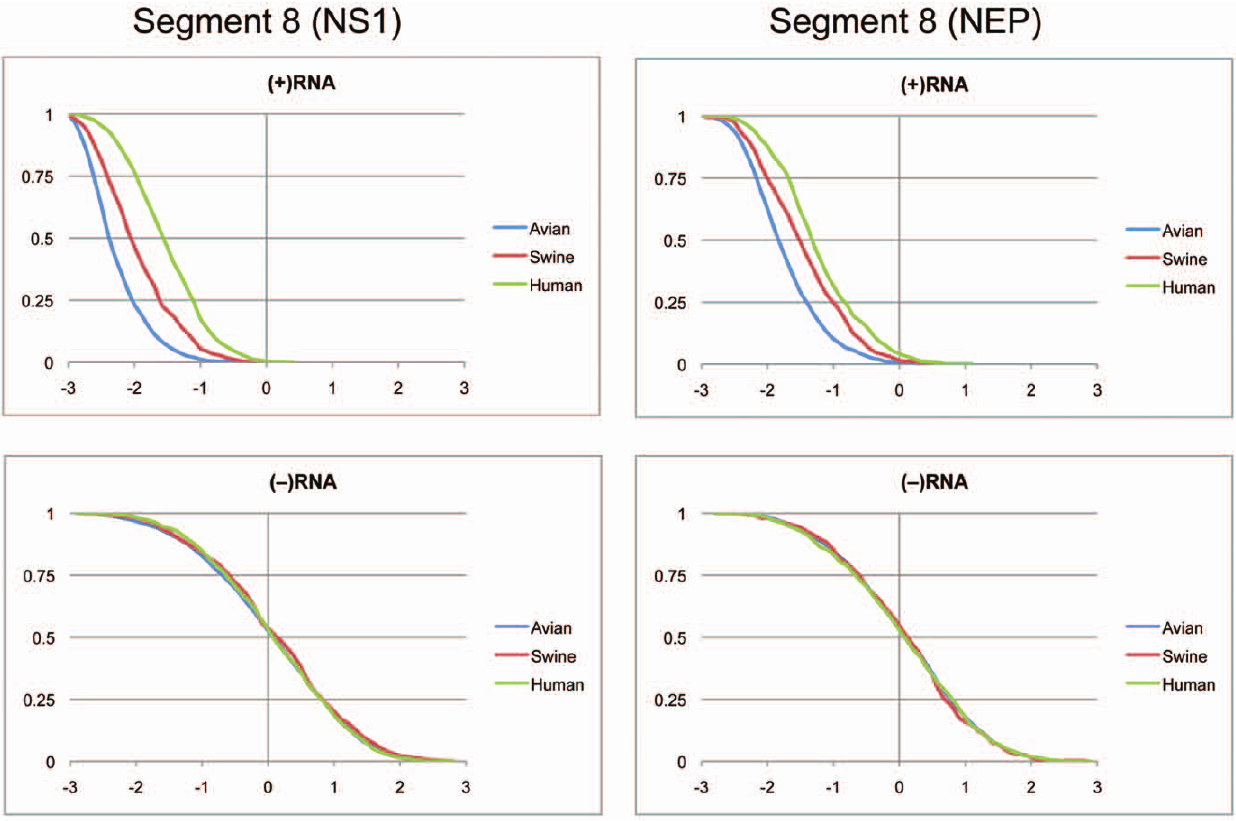
Figure 8. Cumulative distribution plots of z-scores for segment 8 coding regions. NS1 and NEP are shown in the left and right panels, respectively. ( + )RNA and ( 2 )RNA are shown in the top and bottom panels, respectively. See Figure 1 for annotations and details.